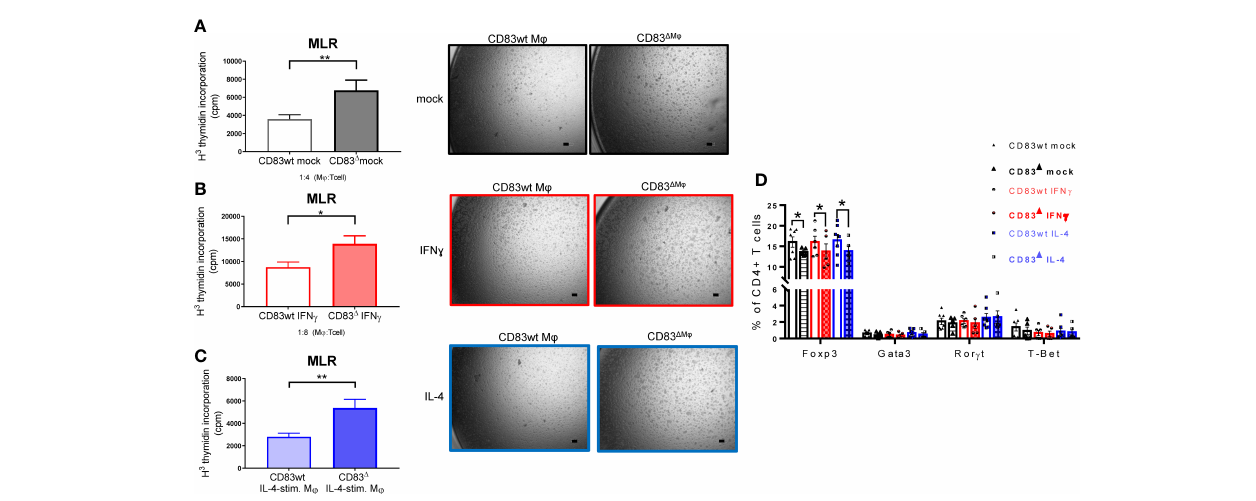
FIGURE 6 CD83-de fi cient M j show enhanced capacity to stimulate allo-reactive T cells. M j were generated from CD83wt and CD83 cKO mice and differentiated using IFN g or IL-4. Afterwards, the medium was discarded and splenocytes derived from BALB/c mice (4x10 5 cells/well) were co-cultured with differentiated M j in 96-well plates, at different M j :splenocyte ratios, as indicated for 48h. T cell proliferation was assessed using tritium (A – C) . Co- cultures of unstimulated, IFN- g - and IL-4 stimulated M j , derived from CD83-de fi cient M j , show enhanced proliferative responses, when compared to co-cultures with CD83wt derived M j (left bar graphs, A – C ). This observation is re fl ected by decreased T cell clusters shown in representative microscopic images ( A – C , right side). (D) Flow cytometric analyses revealed a signi fi cantly decreased frequencies of Tregs (CD4 + Foxp3 + cells) in co- cultures of CD83-de fi cient M j with allo-reactive splenocytes. Statistical analyses were performed by using an Unpaired t-test (A – C) or Two-way ANOVA (D) or the appropriate corresponding non-parametric test (n ≥ 4). Data are represented as mean ± SEM. Experiments were performed at least three times. *p< 0.05; **p<0.01. The absence of asterisks indicates that there is no statistical signi fi